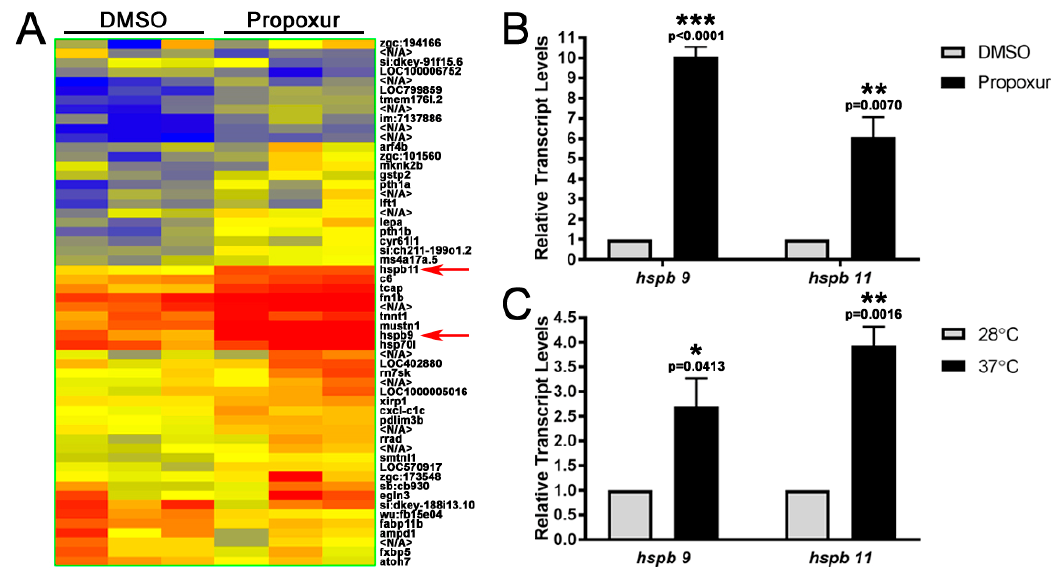
Figure 5. The expression of the small heat-shock proteins hspb9 and hspb11 are increased in propoxur-treated embryos. ( A ) Heat map of 56 genes that were identified by microarray analysis to be significantly regulated by propoxur treatment: Each column represents a separate biological pool of 40 hpf embryos treated with either DMSO or propoxur. Dark blue represents a 2-fold downregulation of expression, whereas dark red represents a 2-fold upregulation in expression. Expressions of hspb9 and hspb11 are indicated by red arrows. ( B , C ) qRT-PCR confirmation of hspb9 and hspb11 upregulation following propoxur treatment and heat shock: The asterisks represent different levels of significance ( p values are shown). Table 1. Top five diseases and biological functions generated by Ingenuity Pathway Analysis (IPA) of genes with significant changes in gene expression in control versus propoxur-exposed groups with the number of genes and percentage of genes in the